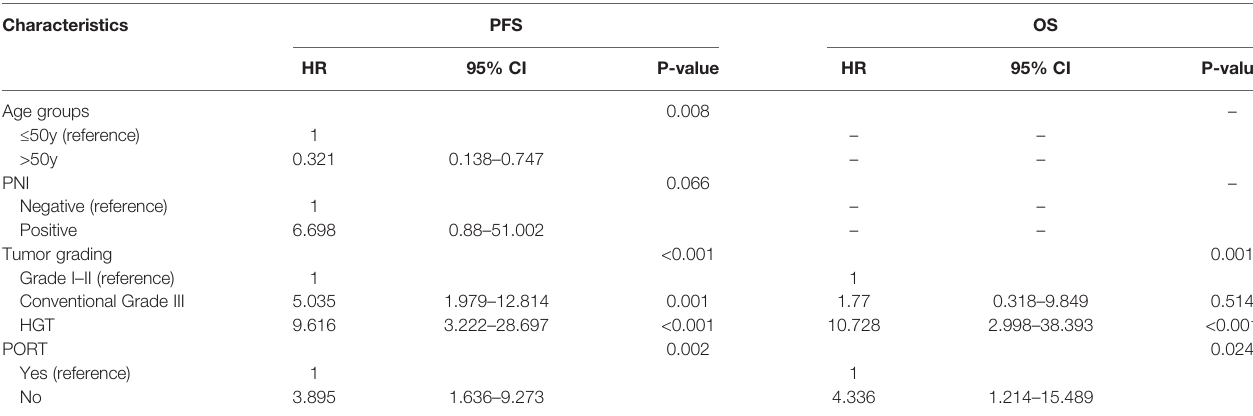
TABLE 6 | Multivariate Cox regression analysis.